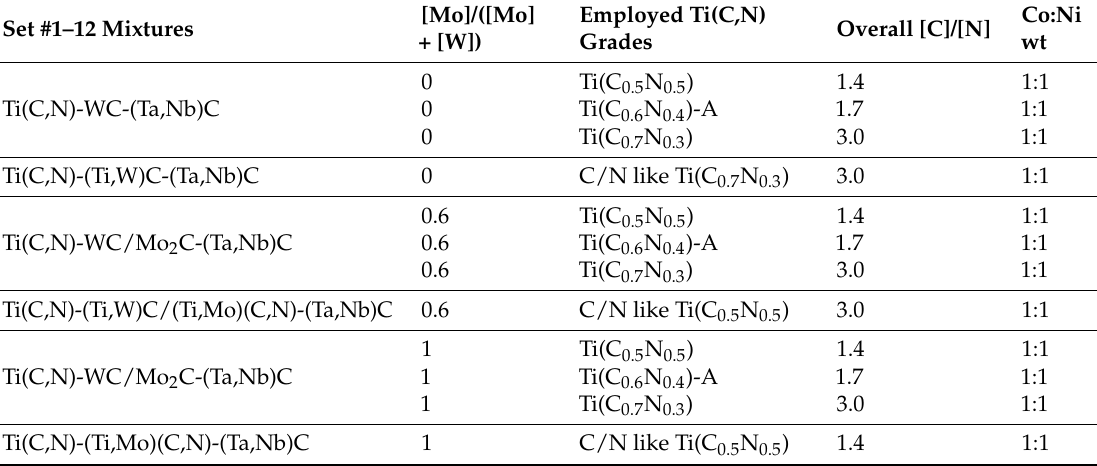
Table 1. Varying [C]/[N] and [Mo]/([Mo] + [W]) ratio, some pre-alloyed hard phases.